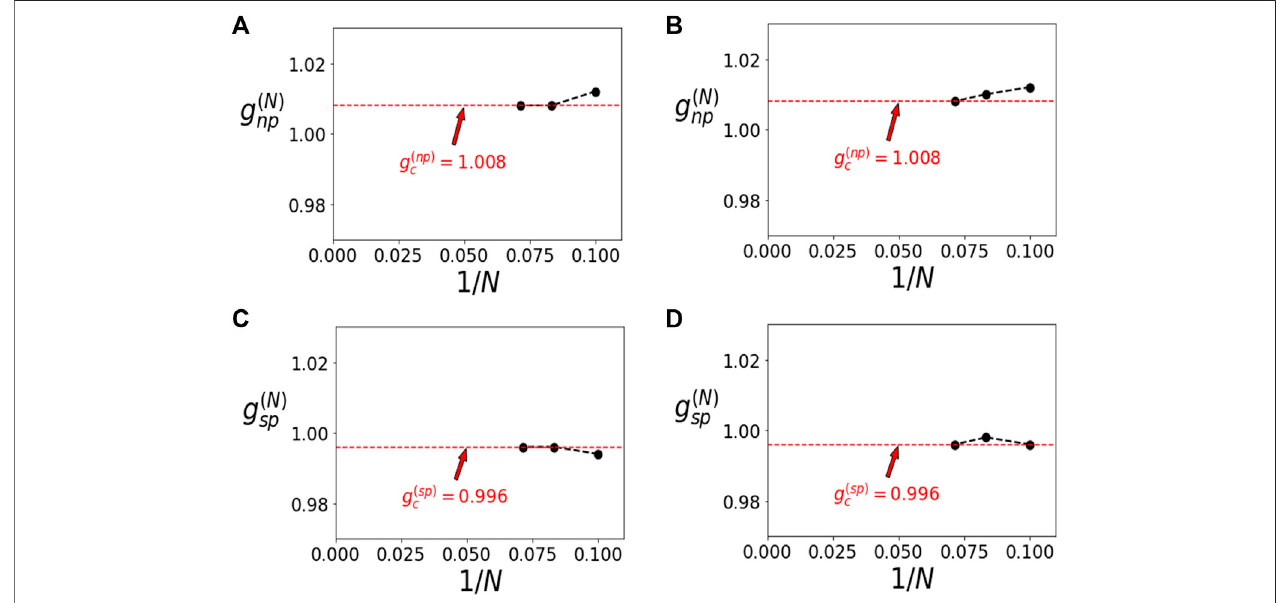
FIGURE 7 | Convergence diagrams for results in Figure 5 . (A – D) correspond to convergence results for data in Figures 5A – D respectively. The same procedure was used as the one shown in Figures 4B,D .